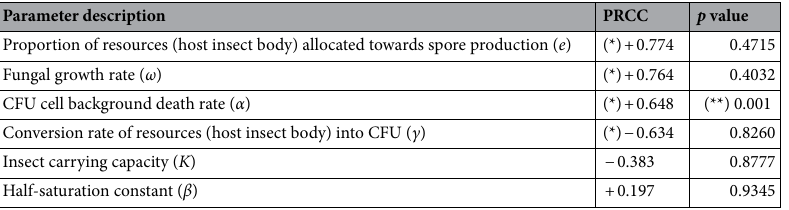
Table 1. PRCC (partial rank correlation coefficient) values and p values for each parameter in the R 0 sensitivity analysis. It summarizes the results and statistical significance in terms of PRCC and p value when changing model parameter values. The sign of PRCC represents the positive (+) or negative (−) response of R 0 to the changed parameter values. (*) denotes PRCCs that are highly different from 0 (− 0.5 ≥ PRCC ≥